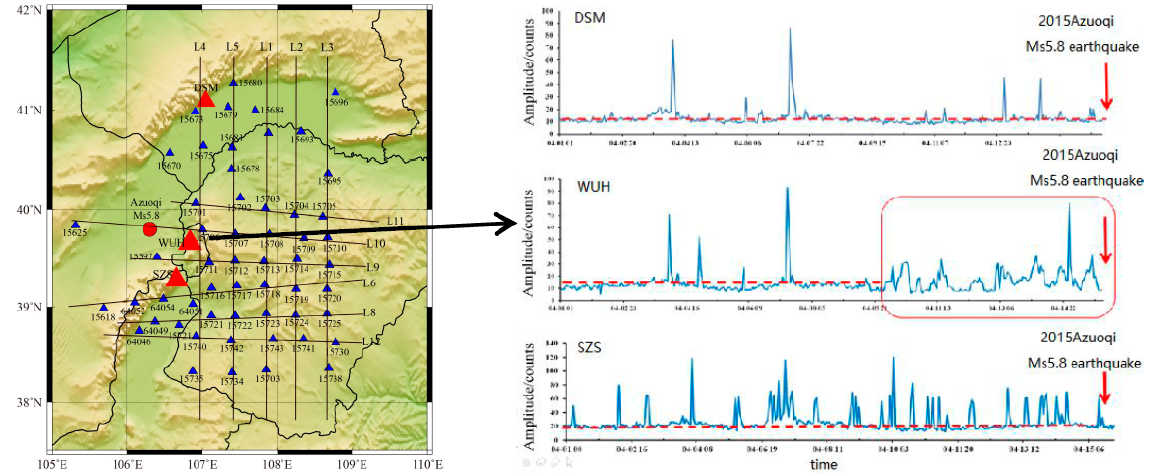
Figure 17. Low-frequency signal characteristics and 15597 in L9 = WUH.